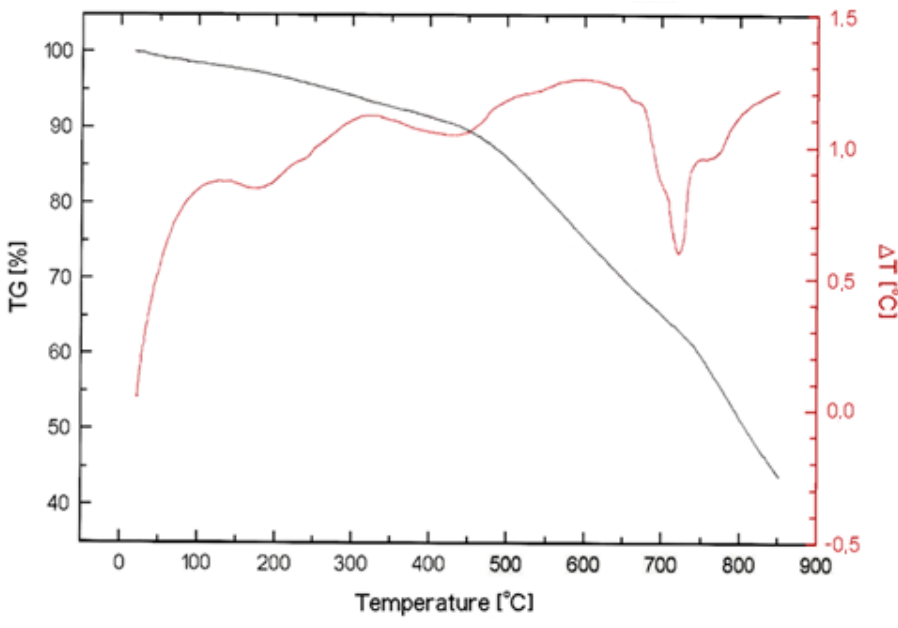
Figure 4. Thermogravimetric analysis (TG)/DTA analysis of filtration cake.